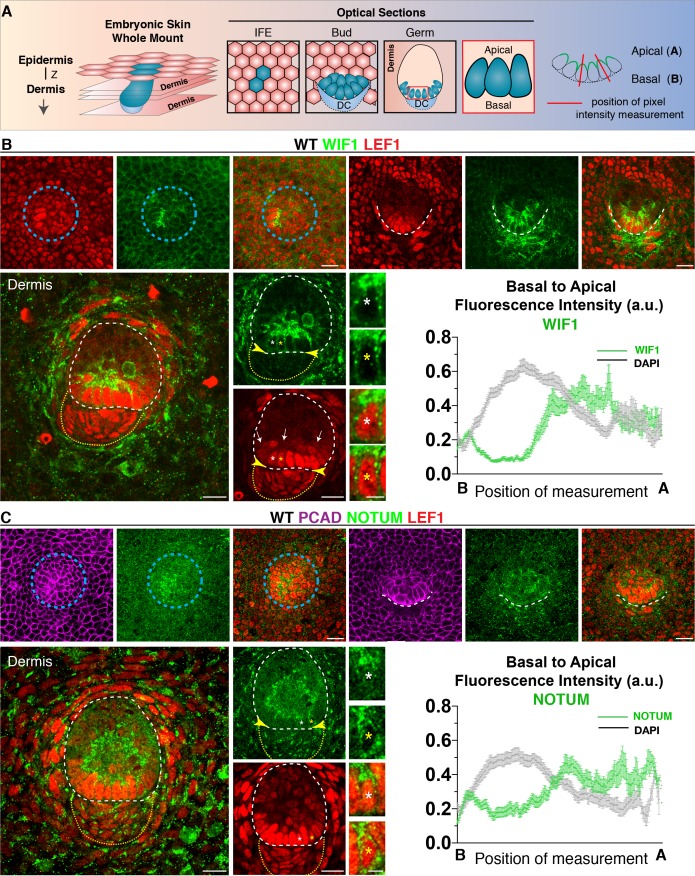
Progenitor cells apically polarize WNT inhibitors.(A) Schematic of whole-mount analysis from embryonic skin with examples of optical sections showing interfollicular epidermis (IFE), bud and germ; position of pixel intensity measurement. Z, plane of imaging from the Z-stack. (B) Anti-WIF1 and (C) anti-NOTUM immunofluorescence in placode, bud and germs reveal an apical accumulation of WIF1 and NOTUM. Pixel intensity profiles of basal hair bud progenitors (n = ≥40 WNT signaling progenitors; mean ± SEM; a.u., arbitrary units). Note also absence of WNT inhibitors in upper region of the dermal condensate (encased by yellow dotted line) at this stage of morphogenesis, leaving a WNT inhibitor free zone (yellow arrowheads) for nuclear LEF1 and WNT signaling at the epidermal-dermal boundary (white dashed line) and a WNT inhibitor high zone in suprabasal hair bud cells (arrows). Blue circular dashed lines outline placodes. White dotted lines demarcate epithelial-mesenchymal boundaries. *Denotes magnified cells, shown at right of each frame. Scale bars: 5 μm magnified cells; all others, 20 μm.Figure 4—source data 1.Source data for the graphs shown in Figure 4.